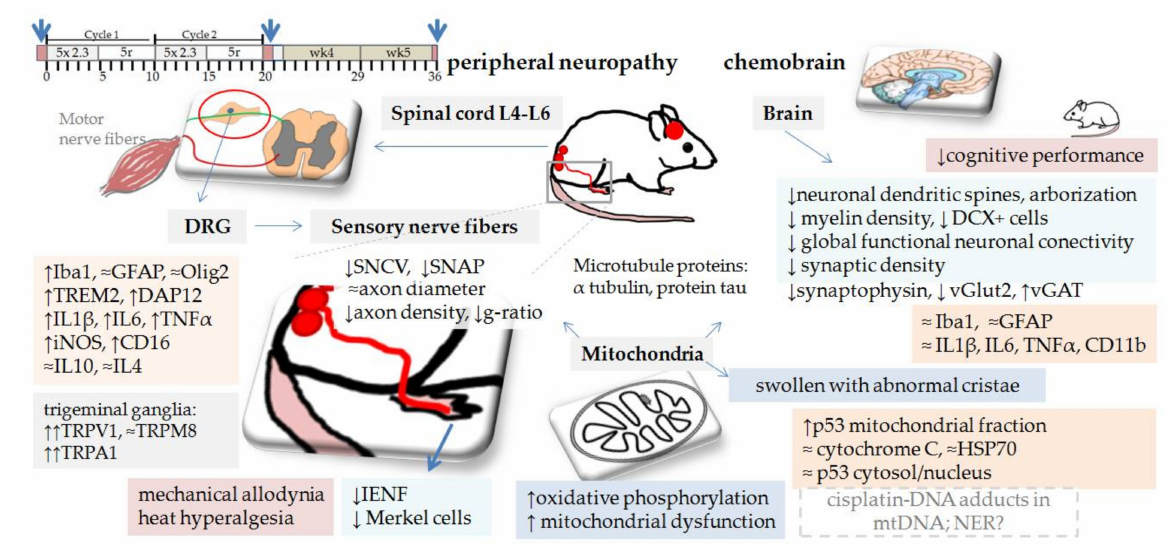
Figure 4. Cisplatin neurotoxicity. In mice, two cycles of cisplatin (2.3 mg/kg/daily for 5 days followed by 5 days recovery; 5d+5r/5d+5r; cumulative dose 23 mg/kg) resulted in reduced density of intraepidermal nerve fibers (IENF) (wk3, and wk5) [152,164] and epidermal Merkel cells [152] in the mouse plantar footpad. Merkel cells, mechanosensory cells actively involved in touch reception (tactile sensation), [165–167] are proposed to underlie sensory dysfunction in diabetic patients and animals [168]. In sensory nerves (sciatic, caudal, tibial) mild hypomyelination with few degenerating axons (reduced density of myelinated fibers without alterations in axon diameter) can be observed together with a slight decrease in the sensory nerve conduction velocity (SNCV; indication of demyelination) and the sensory nerve action potential (SNAP)